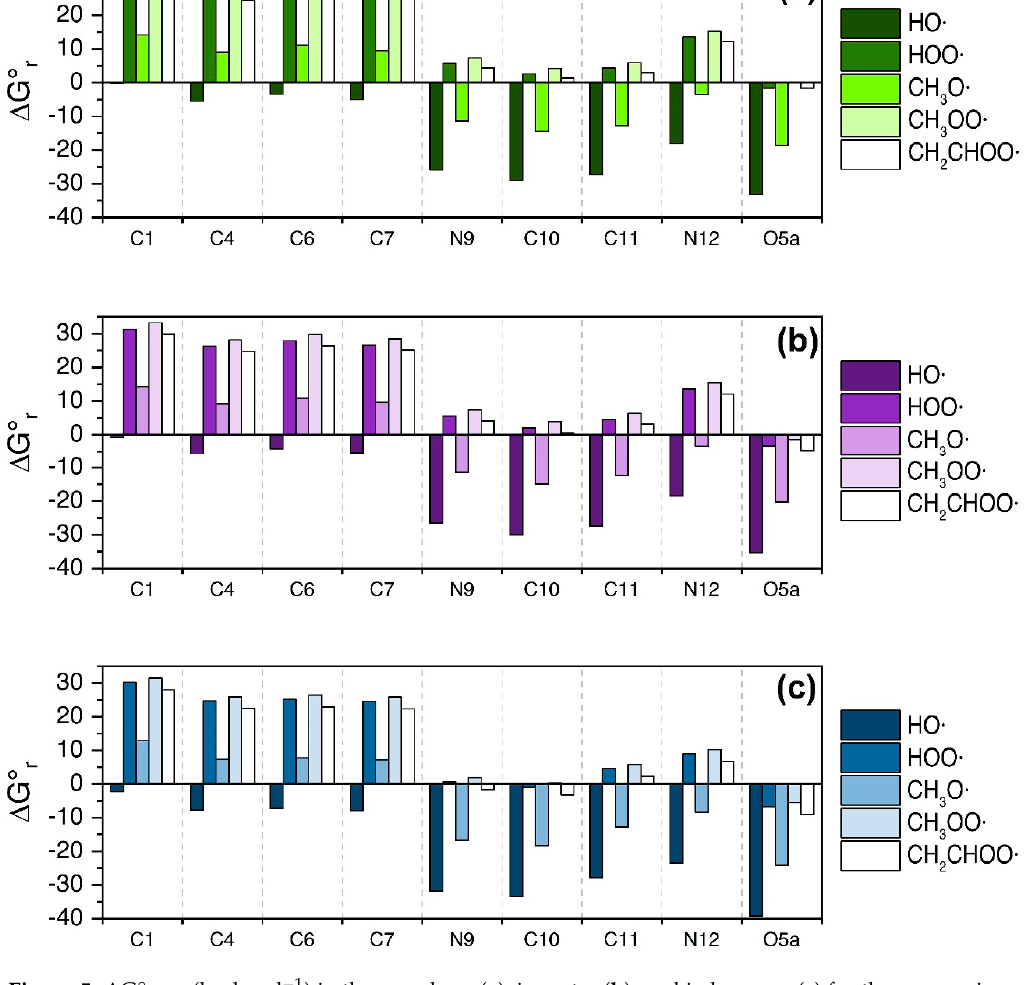
Figure 5. ∆ G ◦ HAT (kcal mol − 1 ) in the gas phase ( a ), in water ( b ), and in benzene ( c ) for the scavenging of HO • , CH 3 O • , HOO • , CH 3 OO • , and CH 2 = CHOO • through HAT from all the available sites of 2 . Level of theory: (SMD)-M06-2X / 6-311 + G(d,p) // M06-2X / 6-31G